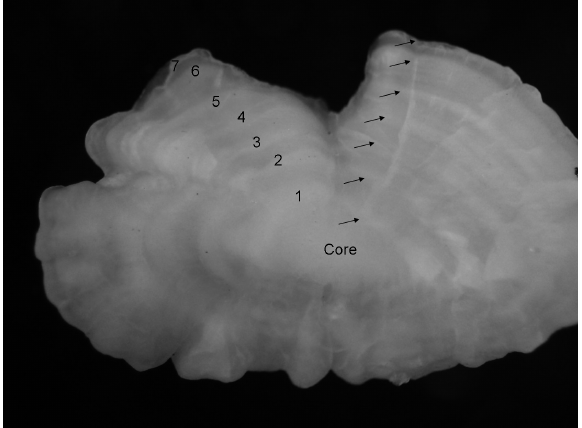
Fig . 2. – sagittal otolith of a 7-year-old toadfish. opaque margin, May 1999, 235 mm L . t